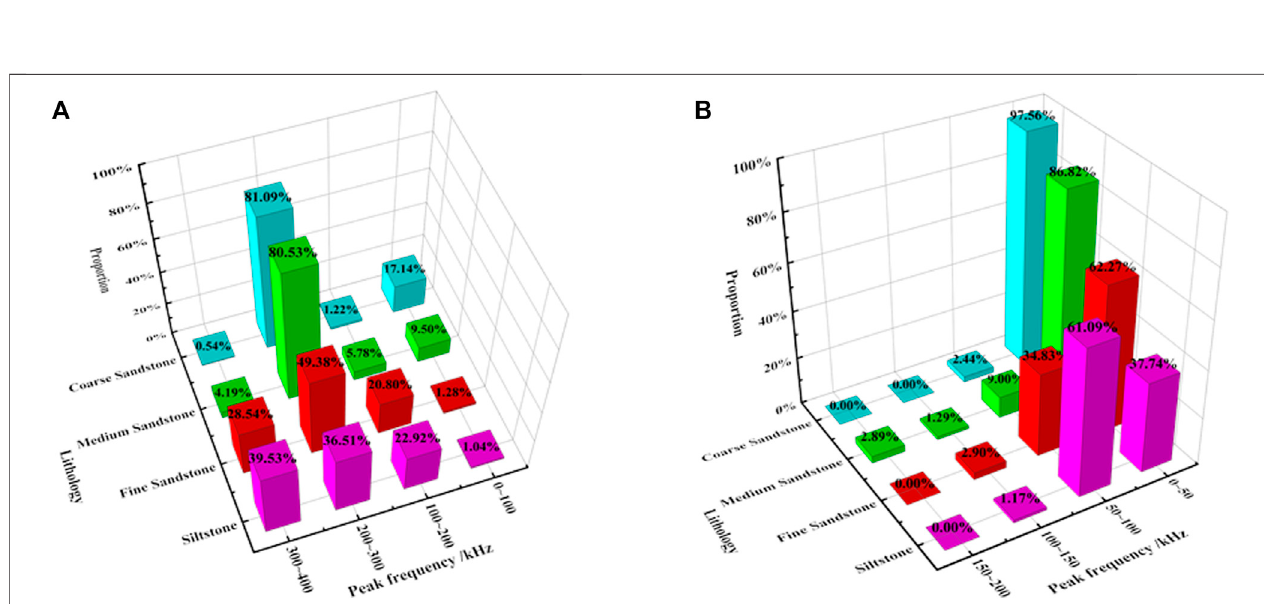
FIGURE 8 | Distribution of peak frequency for typical sandstone with different grain sizes (A) uniaxial compression, (B) Brazilian splitting.